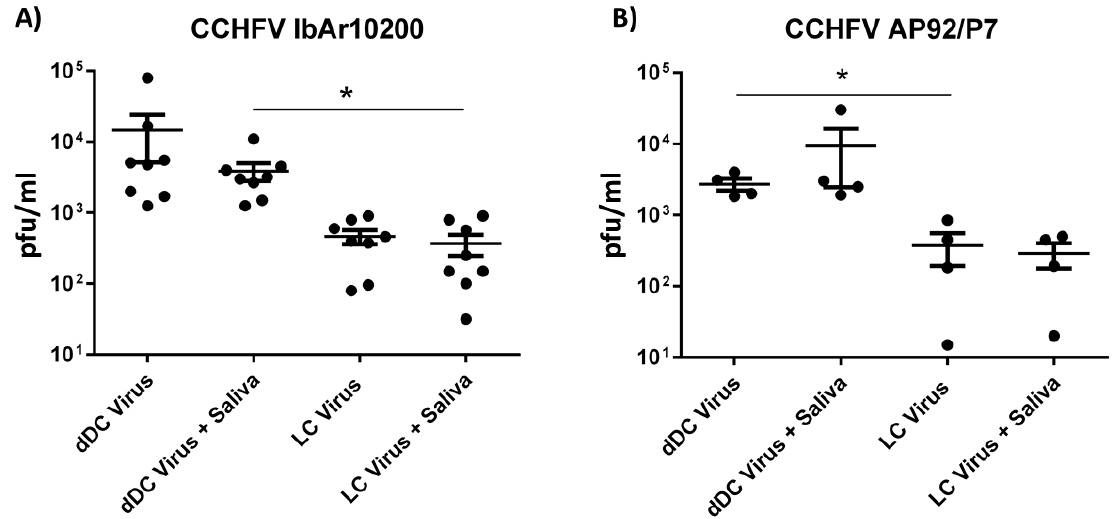
Figure 1. CCHFV titers in supernatant of human APCs. dDC and LC were generated from eight different donors and infected with two strains of CCHFV, IbAr10200 ( A ) and AP92/P7 ( B ), either with tick SGE (10 µ g per well) or without at a MOI of 0.1. Forty-eight hours post infection supernatant was collected and virus titers determined by plaque assay. Significance between mock and indicated treatment groups at p < 0.05 is designated with an asterisk (*) symbol.